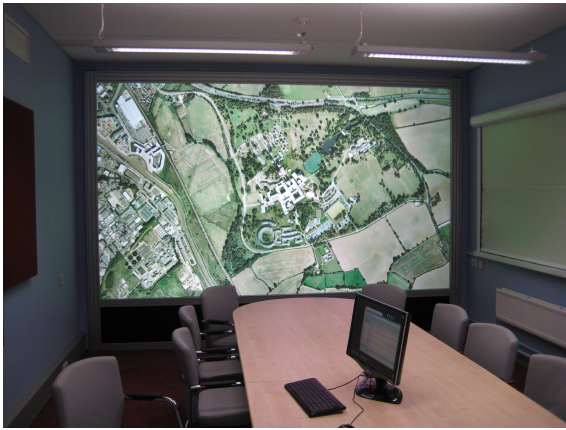
Fig. 2. 8k Auditorium at University of Essex